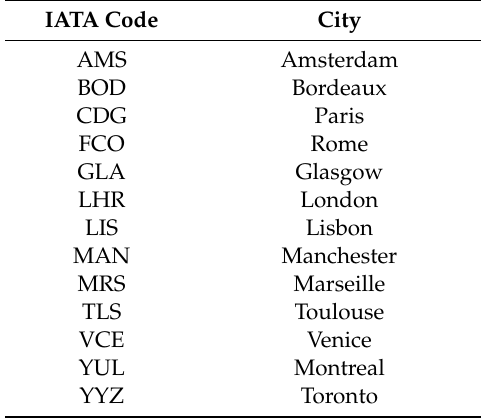
Table 3. International Air Transport Association (IATA) codes for di ff erent